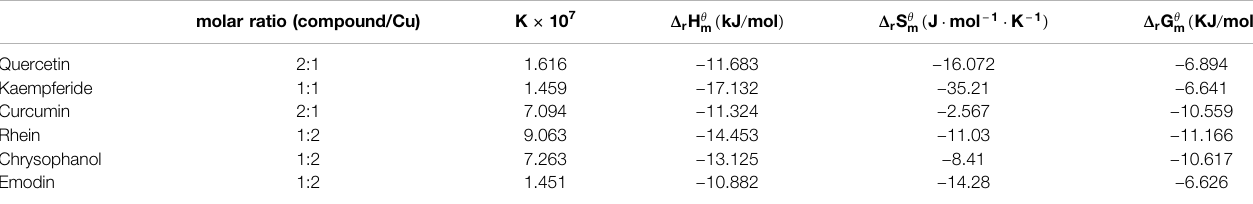
TABLE 5 | Coordination equilibrium constants and thermodynamic constants of copper complexes. molar ratio